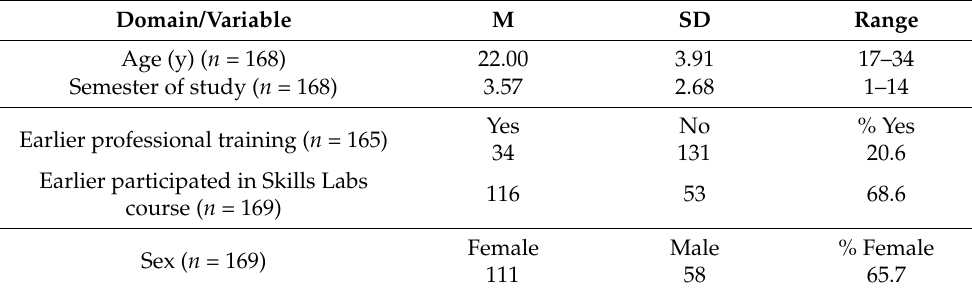
Table 1. Descriptive demographics of course attendees.